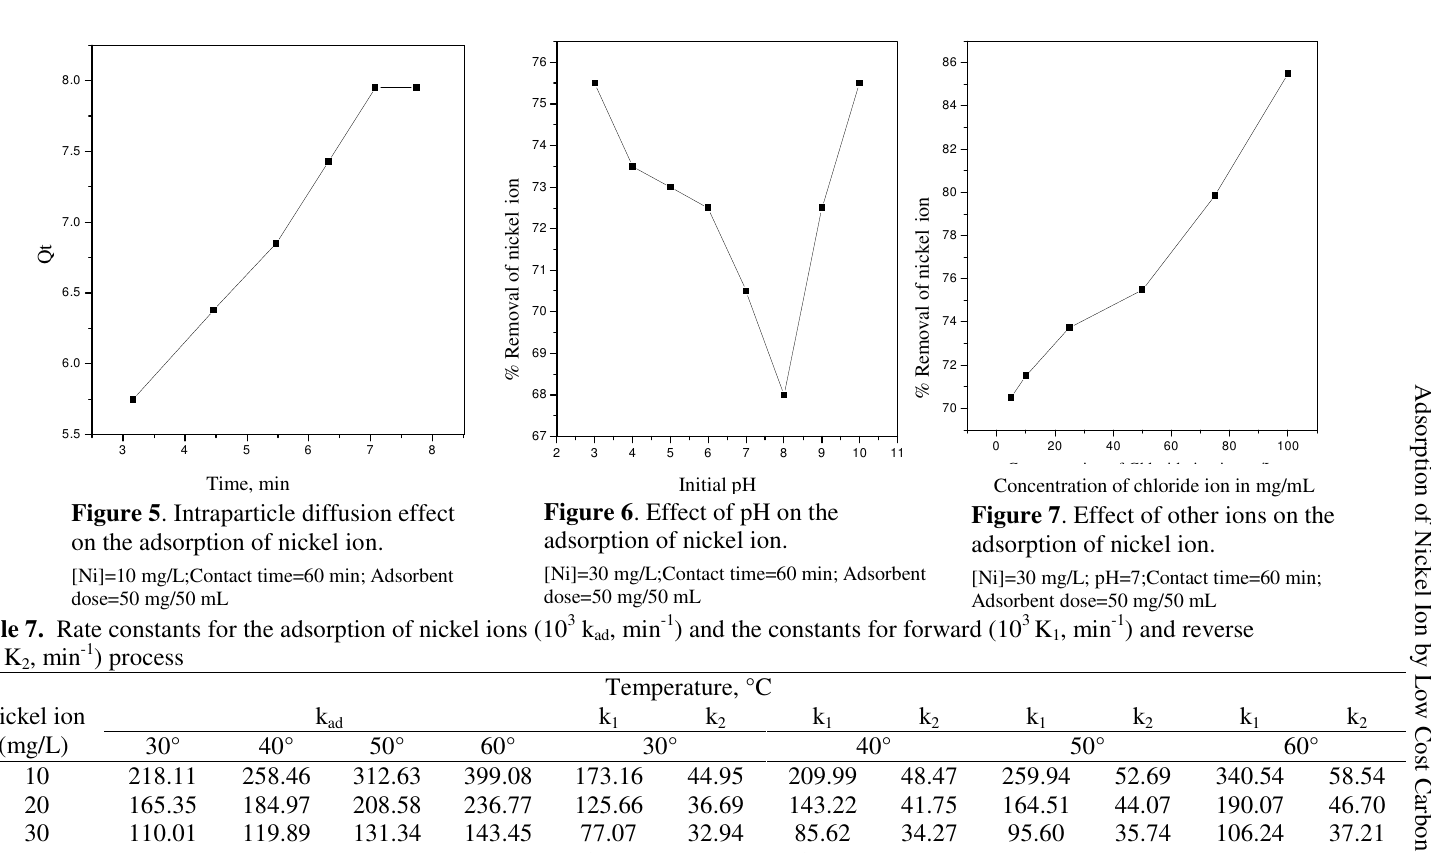
Figure 6 . Effect of pH on the adsorption of nickel ion. , min -1 ) and the constants for forward (10 3 K ad